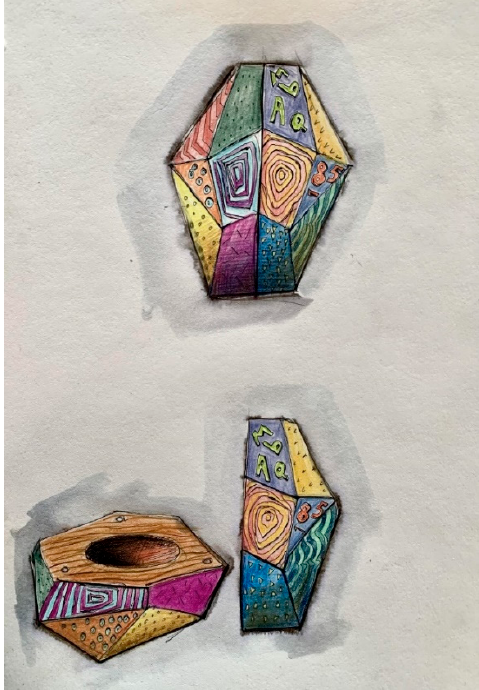
Figure 14. Sketch for color-haptic left and right brain stimulating device, with internal recessed smell receptacle.